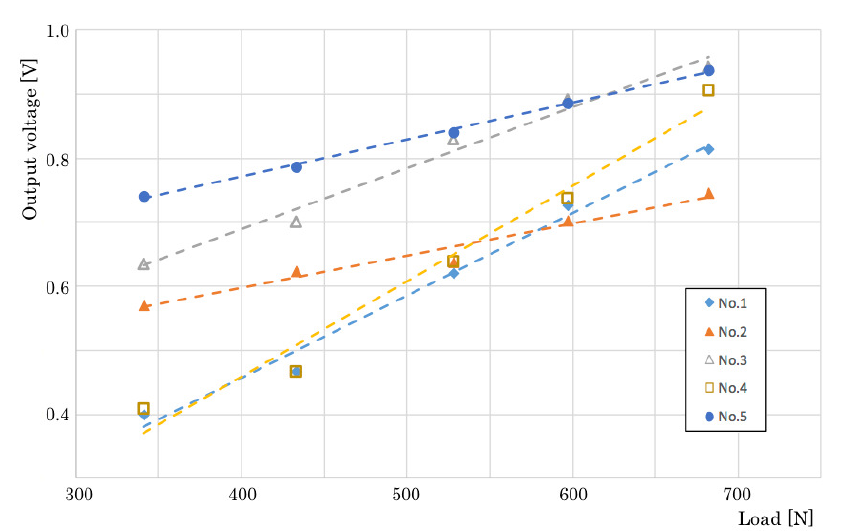
Figure 5. Relation between output voltage and load of sensors.